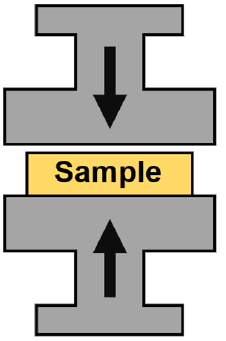
Figure 3. Compression testing configuration.